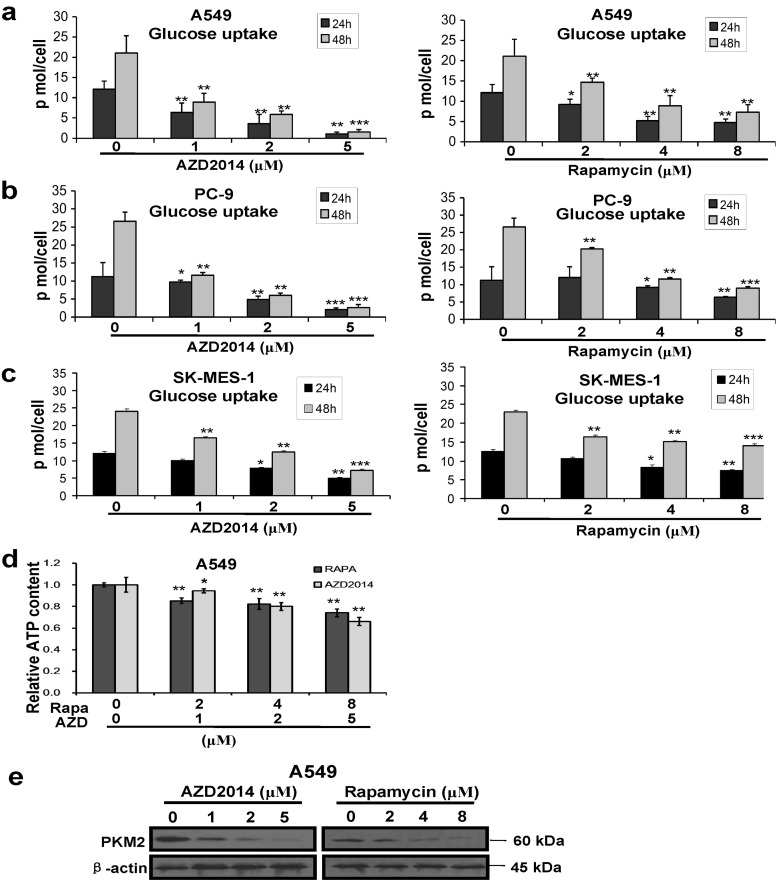
Inhibition of mTOR pathway decreased the level of glycolytic metabolism in lung cancer cells.(a) A549 cells were treated with AZD2014 and rapamycin. (b) PC-9 cells were treated with AZD2014 and rapamycin. (c) SK-MES-1 cells were treated with AZD2014 and rapamycin. After 24 h, the cells were counted and the glucose in the culture media was immediately tested. Then the results were normalized to the number of cells, and performed as pmol/cell. Data represent mean ± SD (n = 3). *P<0.05; **P<0.01; ***P<0.001; control versus AZD2014- or rapamycin-treated cells. (d) and (e) A549 cells were treated with AZD2014 and rapamycin. After 24 h, relative ATP content was determined by using a bioluminescence assay. Then the results were normalized to the number of cells. Data represent mean ± SD (n = 3). *P<0.05; **P<0.01; control versus AZD2014- or rapamycin-treated cells (see Fig 2d). Western blot analysis showed that AZD2014 and rapamycin decreased the level of PKM2 protein in a dose dependent manner. Three independent experiments were performed with similar results, and representative data are shown (see Fig 2e).